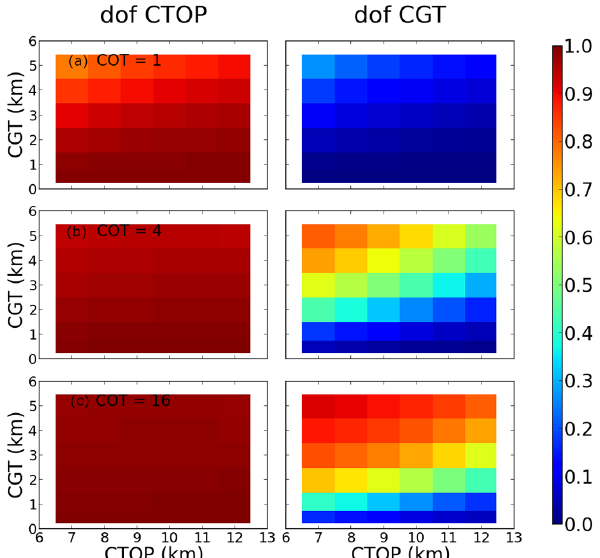
Figure 17. Information content of 3MI A-band with a COT of 16 for different orbits, hence the following angular samplings: (a) AS 1, (b) AS 2, (c) AS 3. Partial DOFs for CTOP (left) and CGT